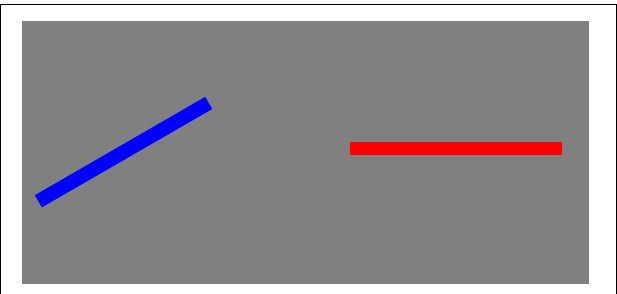
FIGURE 1 | Example of two stimuli presented for dissimilarity judgment.